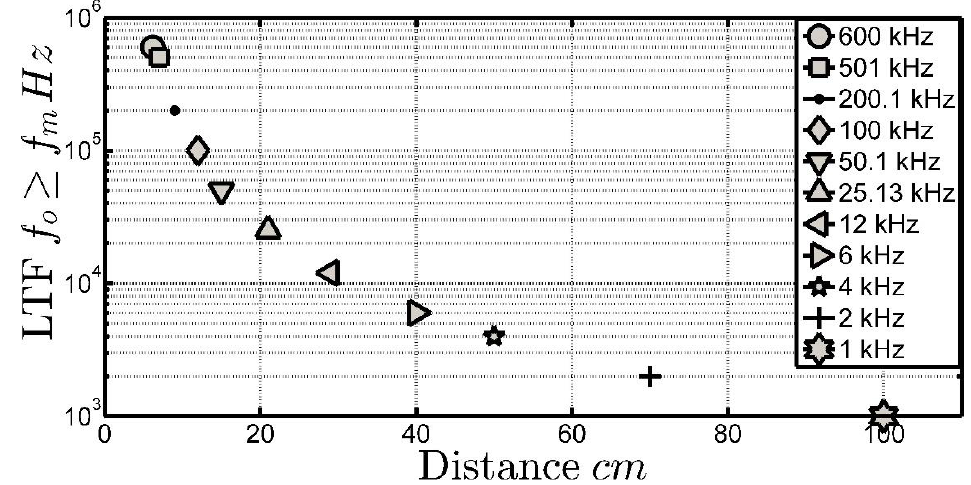
Figure 7. LTF frequency estimation for the different 𝑓 𝑂𝑂𝐾 value and variation link distance.